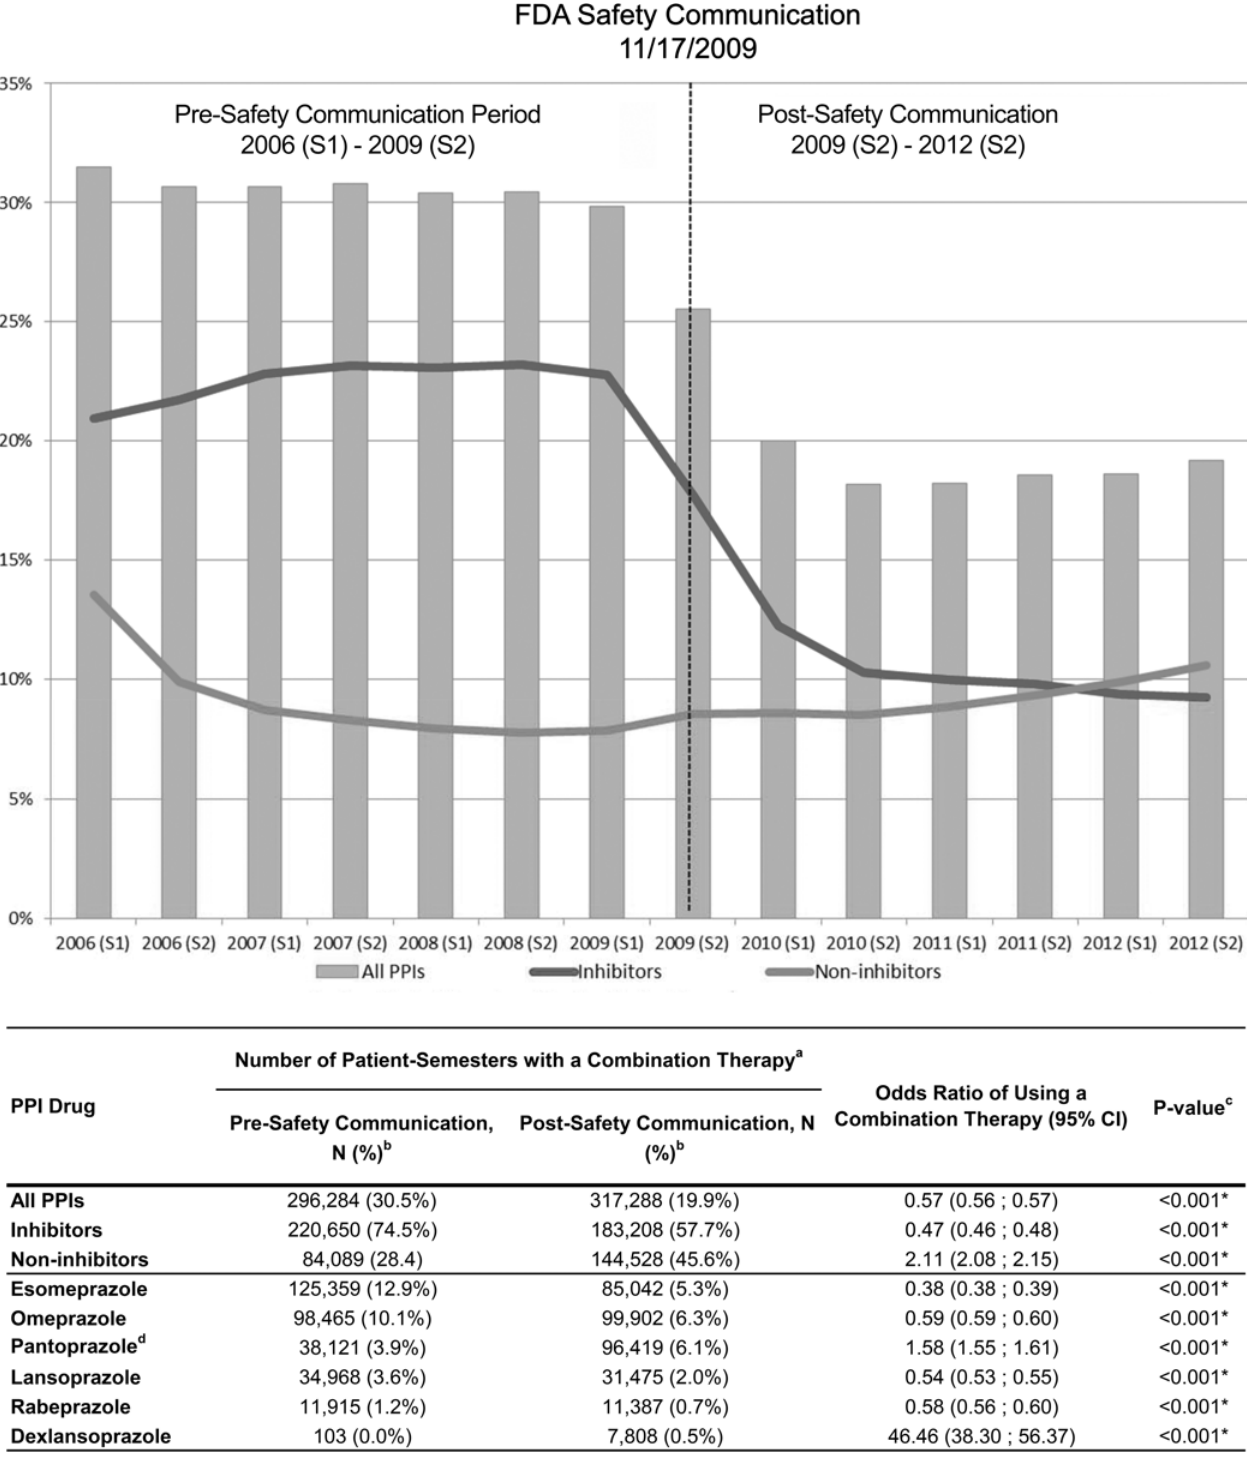
Fig 1. Among clopidogrel users, proportion of patients using clopidogrel-PPI combination therapy over time. Notes: a Total number of patient- semesters pre-safety communication = 272,113; post-safety communication = 1,593,625. b Percentages add up to more than 100% because more than 1 PPI could be prescribed in the same semester. c * indicates that the results are significant at the 5% level (two-sided alpha). d Protonix was first released as a generic, pantoprazole, in August 2007. Abbreviations: CI, confidence interval; PPI, proton pump inhibitor; S, semester.